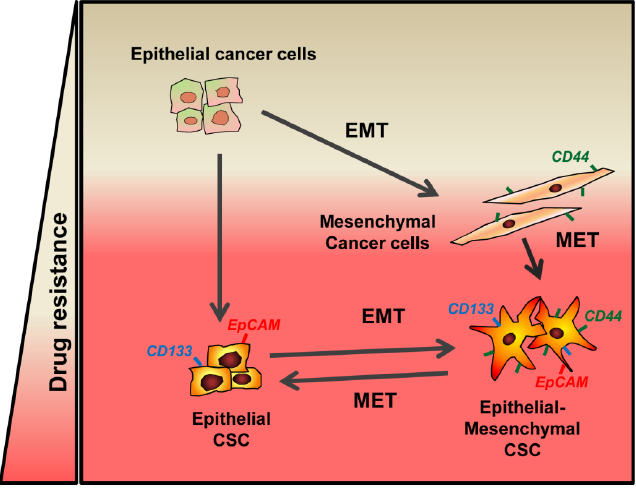
Figure 3. EMT and Stemness in the crossroads towards chemotherapy resistance. See text for details.